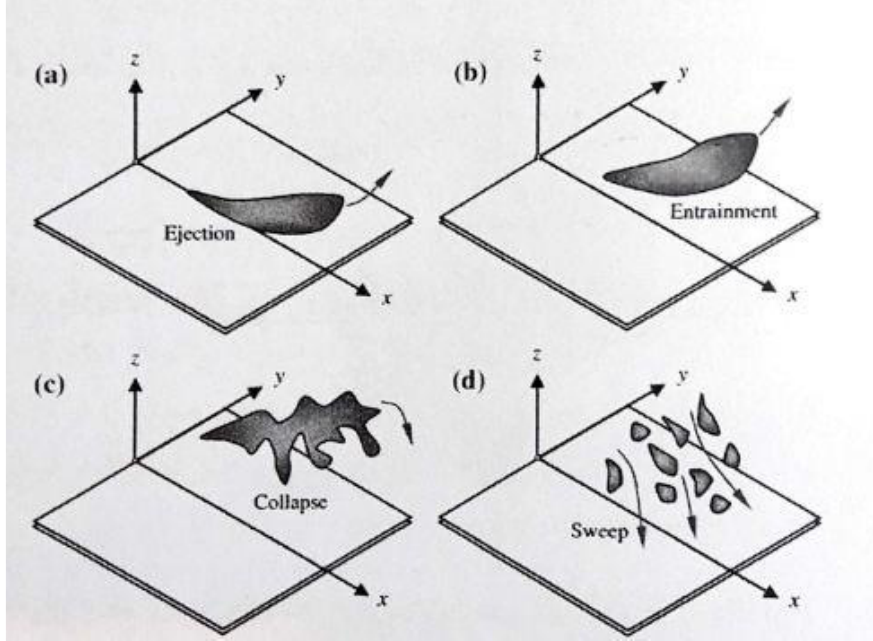
Figure 4. The bursting sequence of events including: ( a ) the beginning of stream streaks separation with the low-velocity flow (ejection), ( b ) the movement of the separated flow into the upper layer flow (except the low-velocity flow), ( c ) the collapse of the separated flow (except for low-velocity flow), and ( d ) moving of high-velocity stream streaks into the bed (sweep).